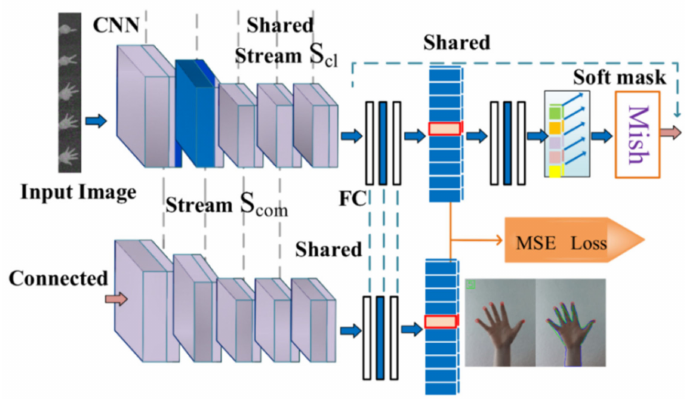
Figure 5. Multi-scale fusion